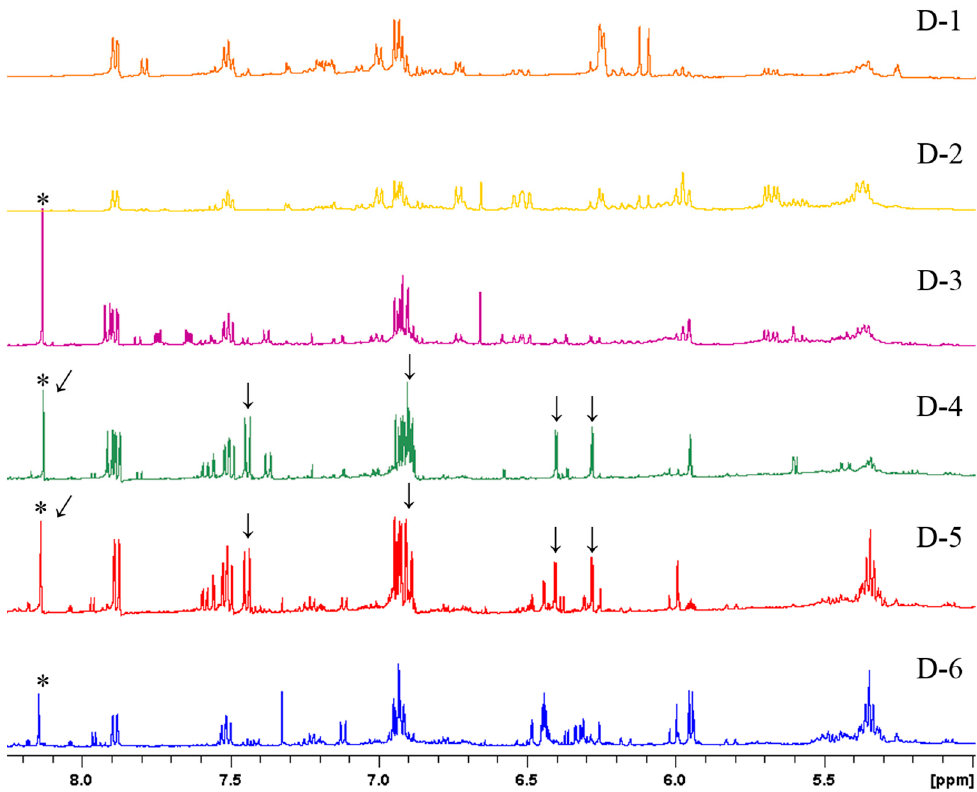
Figure 3. Selected 1 H NMR profiling (acetone- d 6 , 500 MHz) of subfractions D-1 to D-6. * indicates the characteristic singlet signals, δ H 8.13, of isoflavones; ↓ indicates the 1 H spectral data of genistein: δ H 7.44 (2H, d, J = 8.7 Hz), 6.88–6.94 (overlaps), 6.40 (1H, d, J = 2.2 Hz), and 6.28 (1H, d, J = 2.2 Hz).